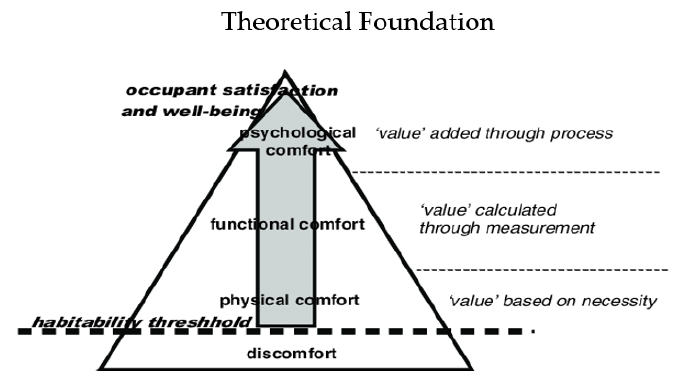
Figure 1. The habitability